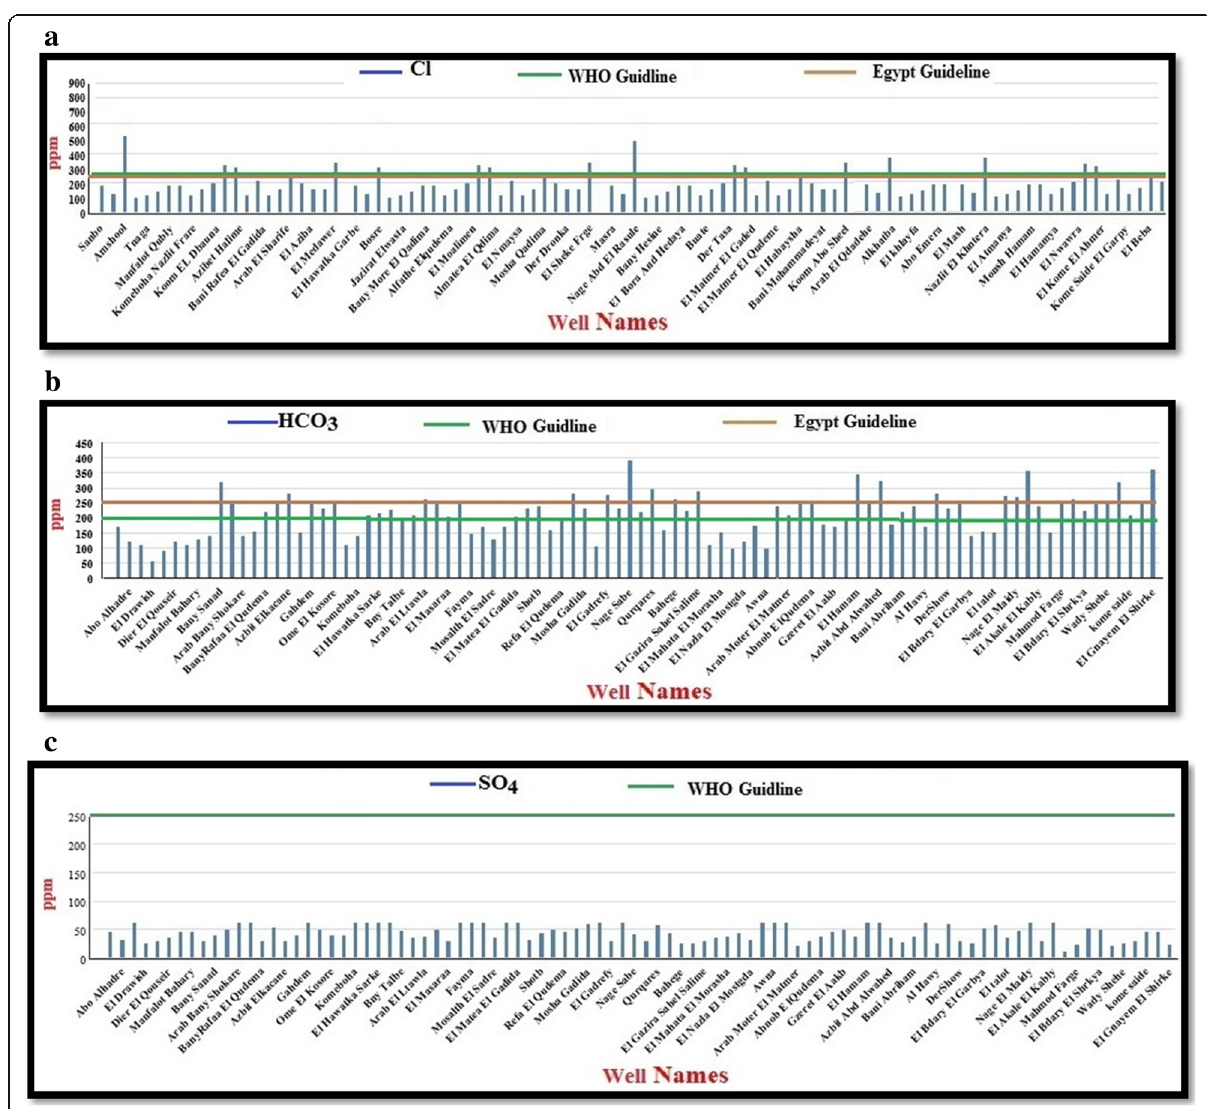
Fig. 11 a Cl, b HCO 3 , and c SO 4 concentration of groundwater samples compared with WHO Guidelines (2004) and Egyptian Higher Committee for Water (2007) guidelines for drinking